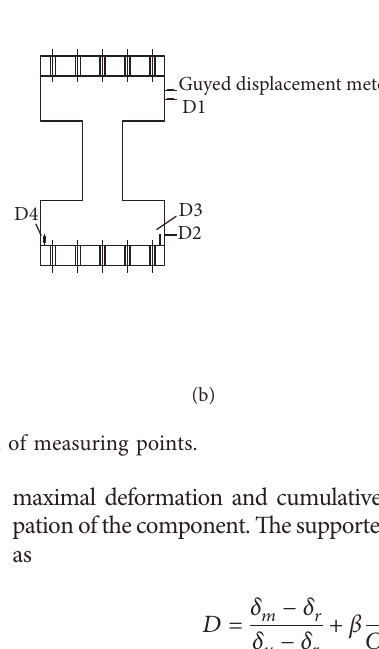
Figure 3: Material diagram of shear wall loading device.